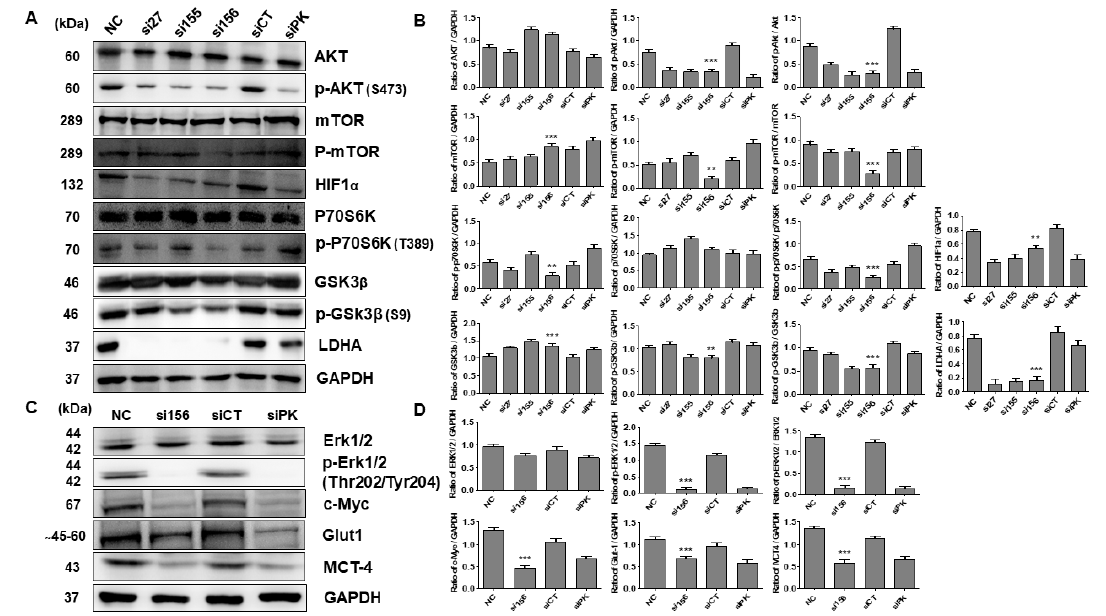
Figure 6. Expression patterns of proteins involved in signaling pathways after PKM2 knockdown by siRNAs. ( A ) E ff ect of PKM2 knockdown on cancer signaling pathways in 786-O cells. Cells were transfected with siRNAs and immunoblotting was performed to evaluate expression levels of signaling pathway proteins. Representative blots are shown. ( B ) Band intensities were measured and represented as bar graphs relative to GAPDH level. Ratios of p-AKT / AKT, p-mTOR / mTOR, p-GSK3 β / GSK3 β , and p-p70S6K / p70S6K were measured and depicted as bar graphs. One-way ANOVA was used to compare means of di ff erent groups. Di ff erences between means were considered significant at p < 0.05 using Tukey’s multiple comparison test; ** p < 0.01, and *** p < 0.001 as compared with normal control cells. ( C ) E ff ect of PKM2 knockdown on expression levels of glycolytic signaling proteins. PKM2 knockdown downregulated expression levels of various glycolytic proteins, thereby reducing glycolysis in PKM2 siRNA-transfected 786-O cells. Representative blots are shown. ( D ) Band intensities were measured and illustrated as bar graphs relative to GAPDH level. Ratio of p-ERK1 / 2 / ERK1 / 2 was